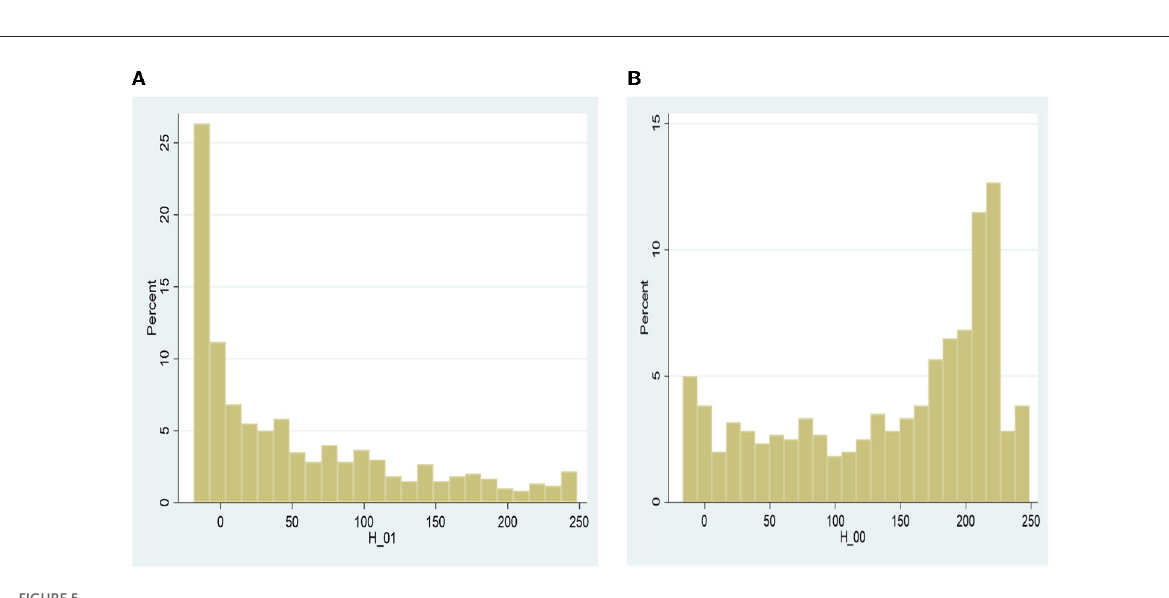
FIGURE5 Comparison of yield (Kg/Ha) distributions at the technology frontier—indirect effect. (A) Mediated-non-adopters, (B)